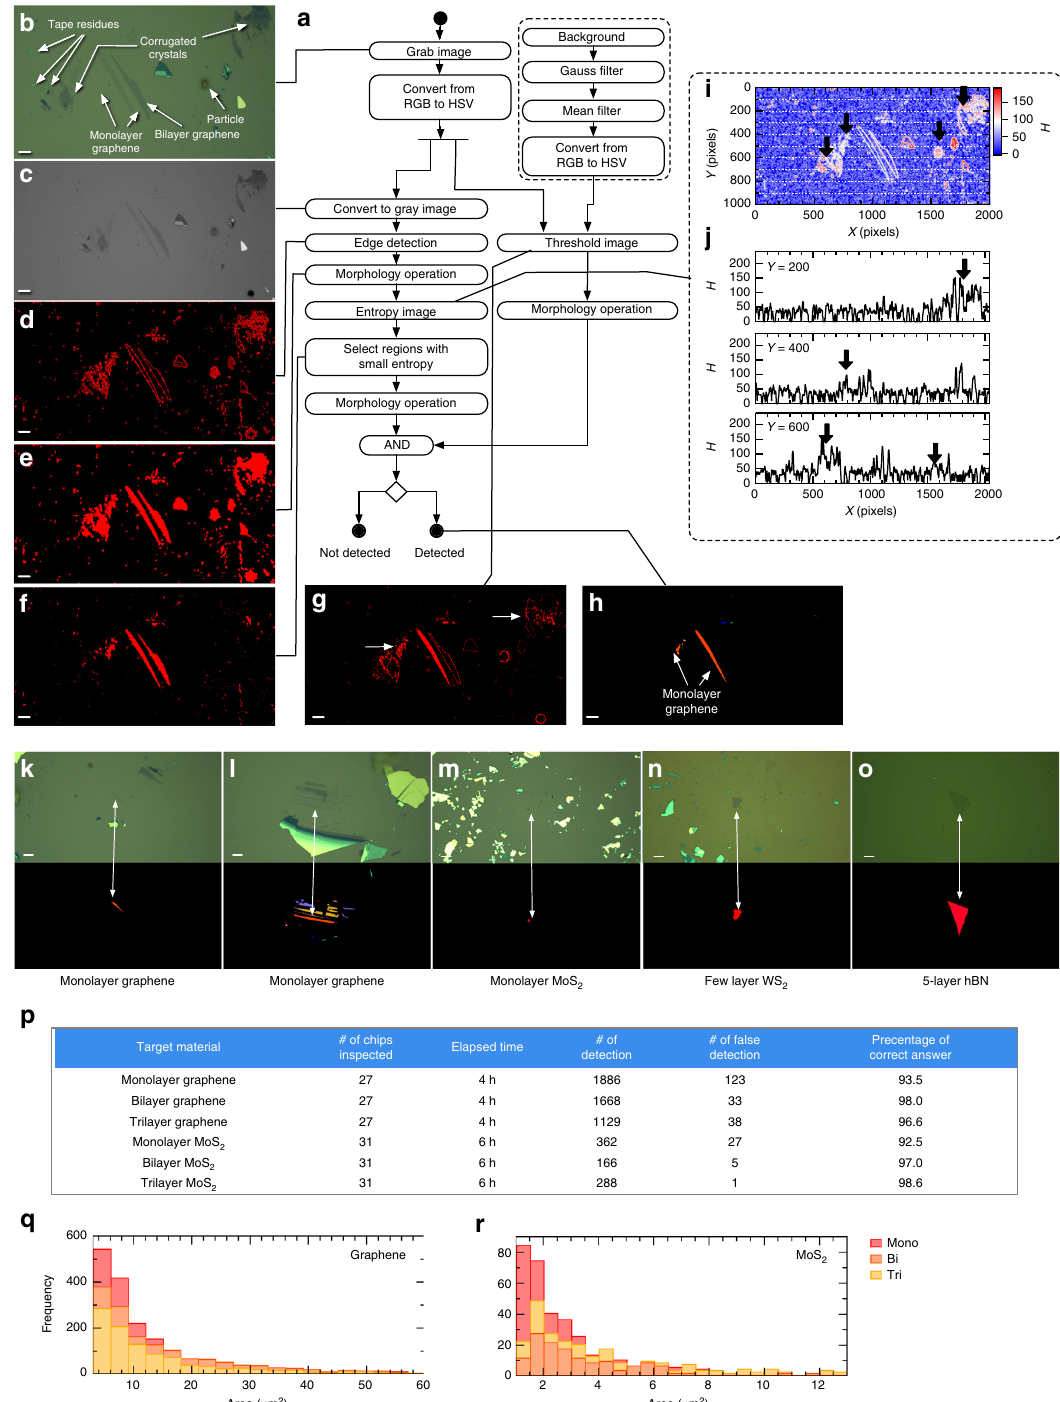
Fig. 4 The pipeline and results of image processing algorithm. a Schematic of processing algorithm for detecting atomically thin 2D crystals from optical microscope images. b Optical microscope image of exfoliated graphene fl akes on SiO 2 /Si chips, where the scale bar represents 10 µ m. The image includes: monolayer graphene, bilayer graphene, Scotch tape residues, collapsed fl akes, and Si particles. c – h Representative images generated at each step. The correspondence between images and blocks are indicated by solid lines. The scale bars represent 10 μ m. i Entropy H extracted from the optical microscope image in c with a mask size of 9 × 9 pixels. j Line cuts of i at Y = 200, 400, and 600 pixels (from top to bottom). The thick black arrows indicate the positions of particles, Scotch tape residues, and corrugated graphene fl akes. Results of the detection algorithm presented applied to k , l monolayer graphene, m monolayer MoS 2 , n a few layers of WS 2 , and o fi ve-layer hBN. The scale bars represent 10 μ m. The top panels show the input optical microscope images; the bottom panels show regions extracted as 2D crystals. p Performance metrics for the proposed automated searching system. q , r Size distributions of exfoliated graphene ( q ) and MoS 2 ( r